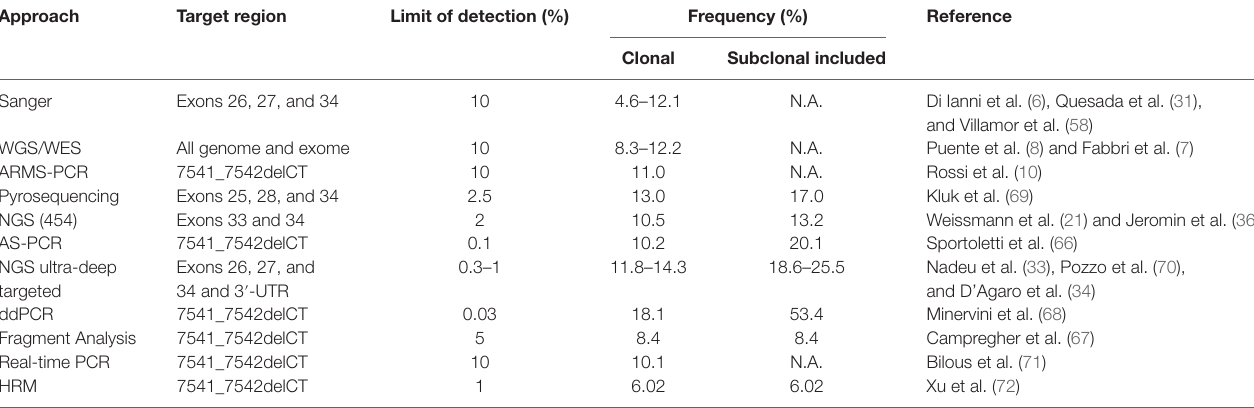
TABLe 2 | Comparison between different molecular methods used to identify NOTCH1 mutations.